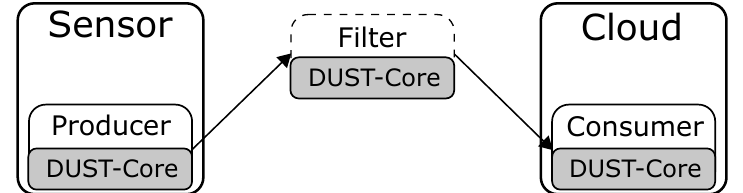
Figure 4. The streaming configuration from sensor to cloud. The filter can be placed on the sensor or on the cloud depending on the devices and the